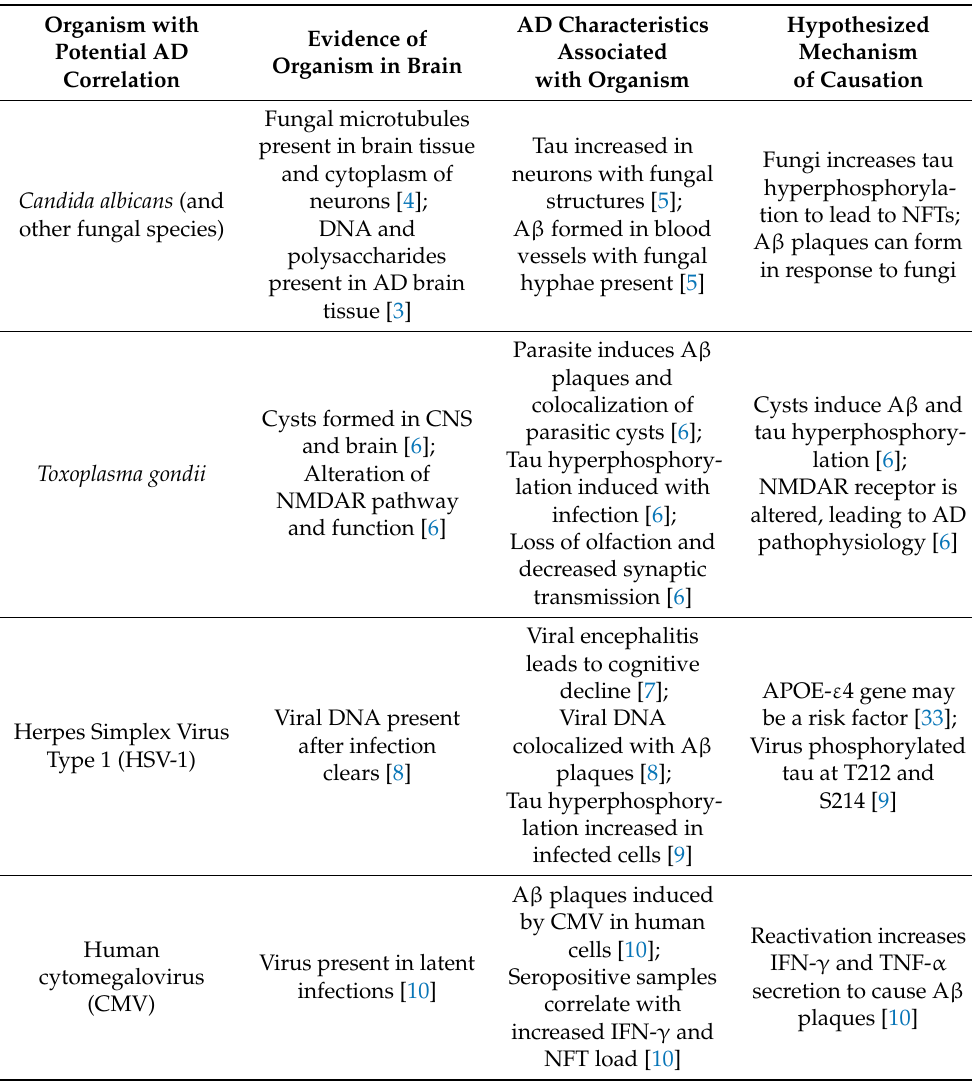
Table 1. A summary of fungi, parasites, and viruses that have been studied in association with AD, the characteristics of AD that are concurrent with the organism, and the hypothesized mechanism of